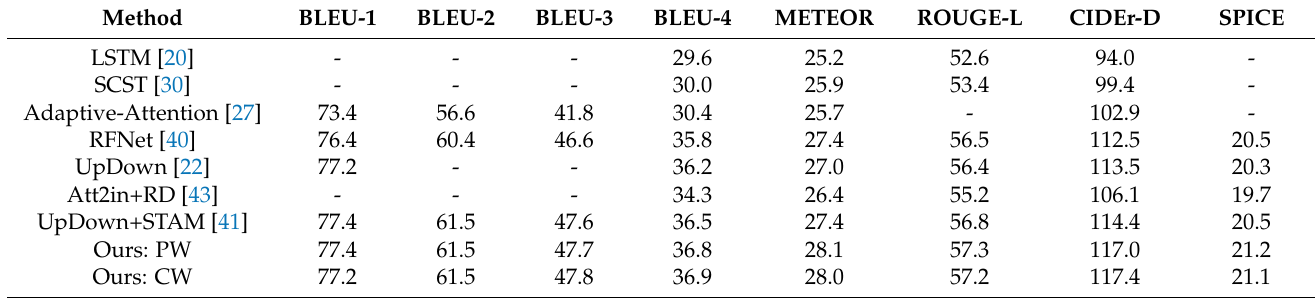
Table 1. The image captioning results of our method and others on the MSCOCO Karpathy test split with cross-entropy loss.